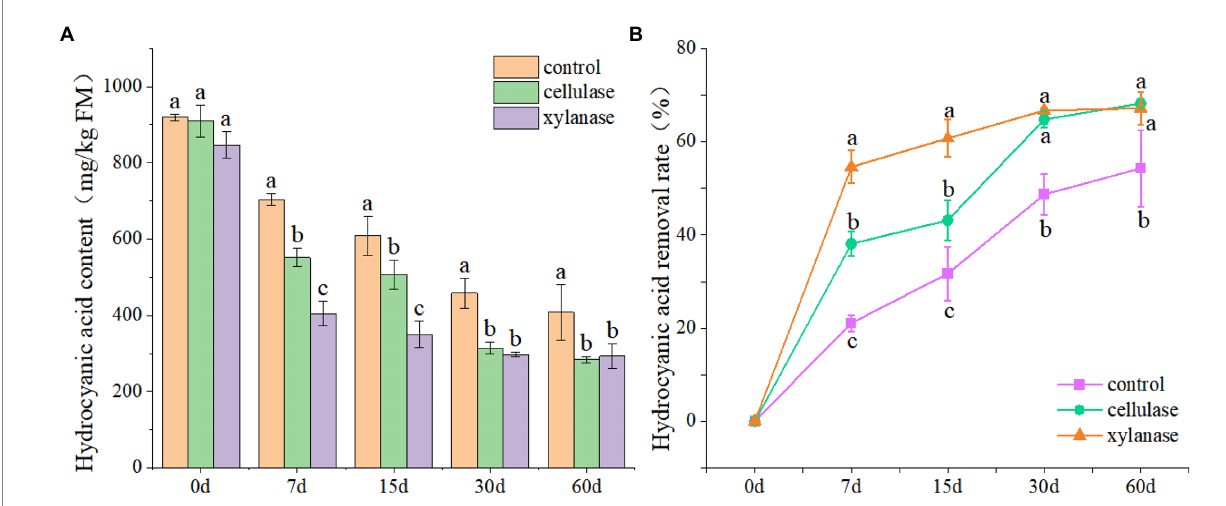
FIGURE 1 Hydrogen cyanide contents (A) and removal rate (B) of ratooning sorghum ensiled with different additives. CK, control; C, cellulase; X, xylanase. Different lowercase letter above the data bar represented significance between concentrations of A. niger within same fermentation time at p < 0.05.